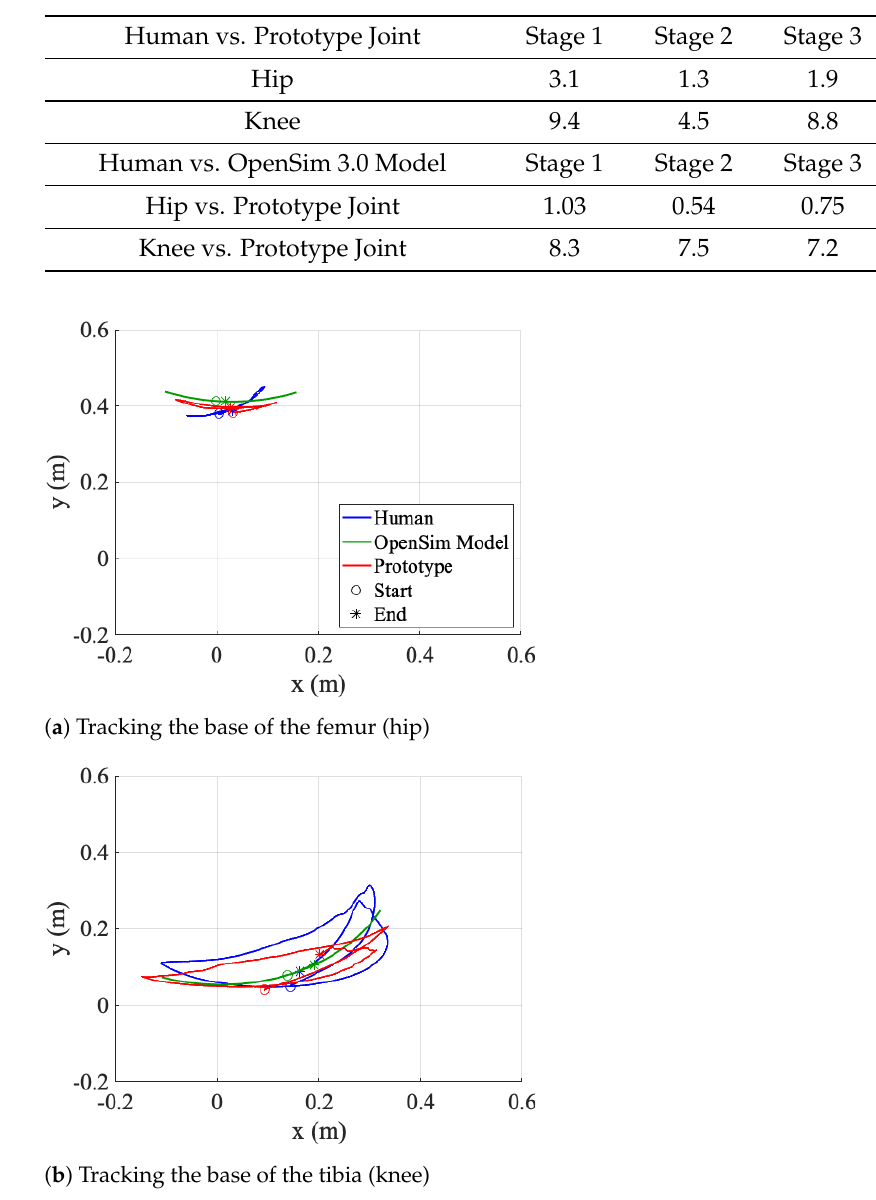
Figure 9. The bottom retro–reflective markers on the human and prototype are the motion–tracked end–effectors. Both end–effectors demonstrate similar behavior, validating the kinematics of the proposed design. During the gait motion, ‘o’ is the start, and the ‘*’ is the